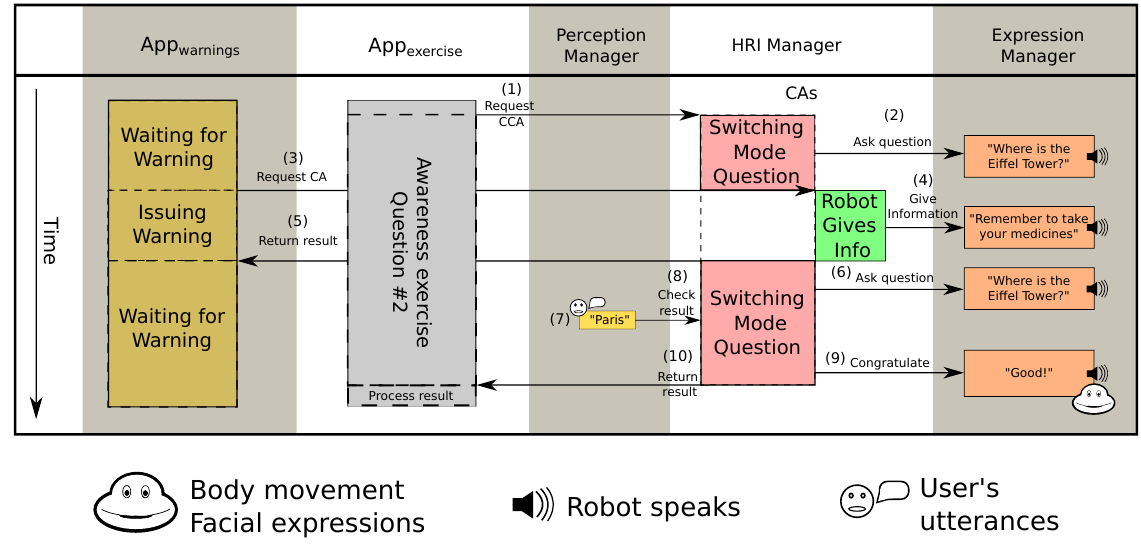
Figure 11. Example of a situation with several CAs with different priorities. The boxes represent actions performed by the different agents and the arrows represent the connections between these actions. Numbers will be referenced in the text to help the